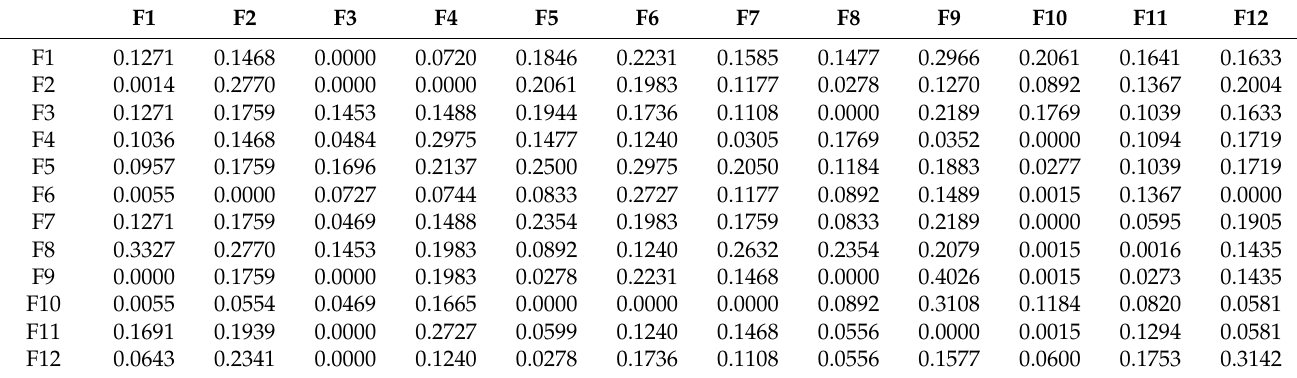
Table 9. The crisp strength–influence matrix.